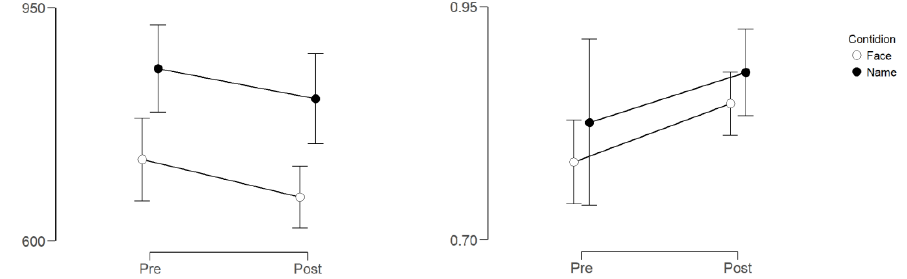
Figure 3. Differences PRE versus POST moments for the distracting stimuli on the face and name recognition conditions. On the left, differences on latencies. On the right, differences on accuracy.